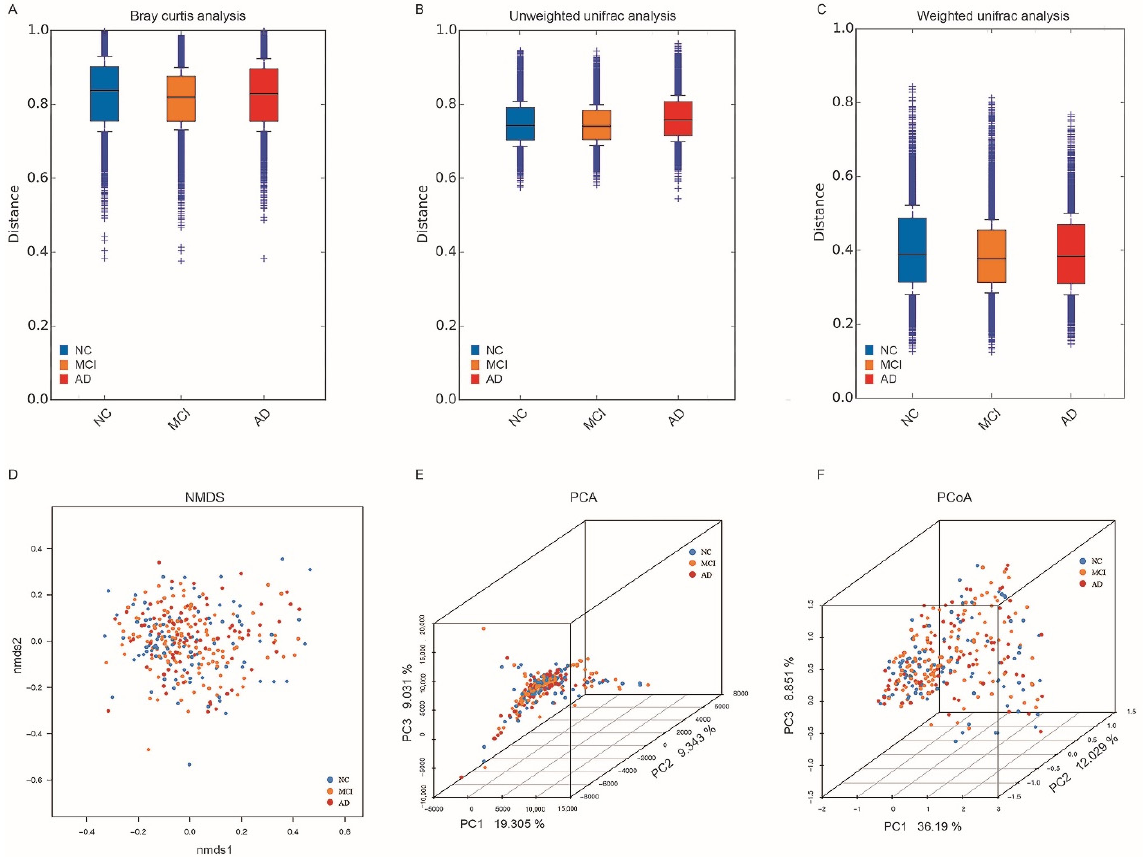
Figure 2. Beta diversity analysis in NC, MCI, and AD. ( A – C ) The beta diversity of NC, MCI, and AD by bray–Curtis ( A ), unweighted unifrac ( B ), and weighted unifrac ( C ) analyses. ( D ) Non-metric multidimensional scaling (NMDS) analysis of the gut microbial in NC, MCI, and AD. ( E ) Principal component analysis (PCA) among the three groups. ( F ) Principal co-ordinates analysis (PCoA) among the three groups. NC, cognitively normal controls; MCI, mild cognitive impairment; AD, Alzheimer’s disease; Nmds, non-metric multidimensional scaling; PCA, principal component analysis; PCoA, principal co-ordinates analysis.